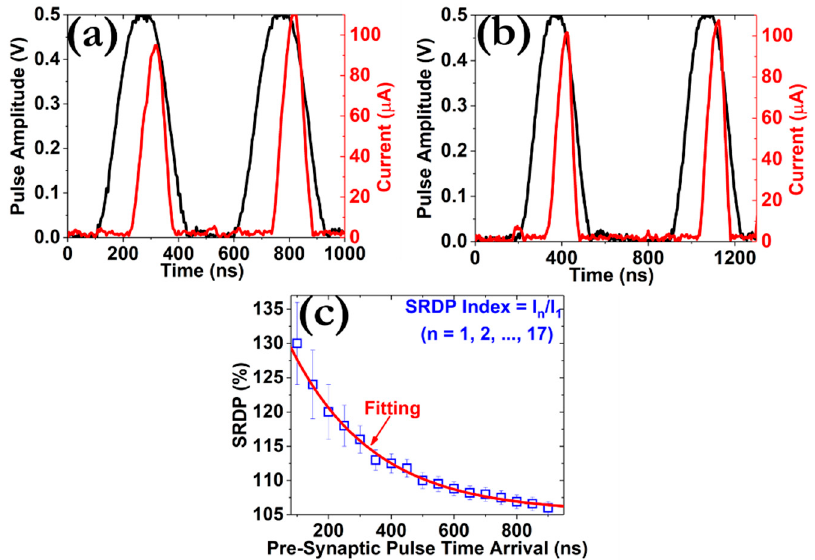
Figure 9. Demonstration of the PPF effect as a function of the time interval between the pre-synaptic pulses. Seventeen different pulse intervals were tested by applying two successive pulses of 0.5 V/100 ns; ( a , b ) depict the post-synaptic responses for a delay time of 100 and 200 ns, respectively. ( c ) Distribution of the spike-rate dependent plasticity ( SRDP ) index (I n /I 1 ) calculated by two consecutive pulses with time interval 100 ≤ Δ t ≤ 900 ns (I 1 , 1st post-synaptic current; I n , n th post-synaptic current, n = 1, 2, 3, . . . ,